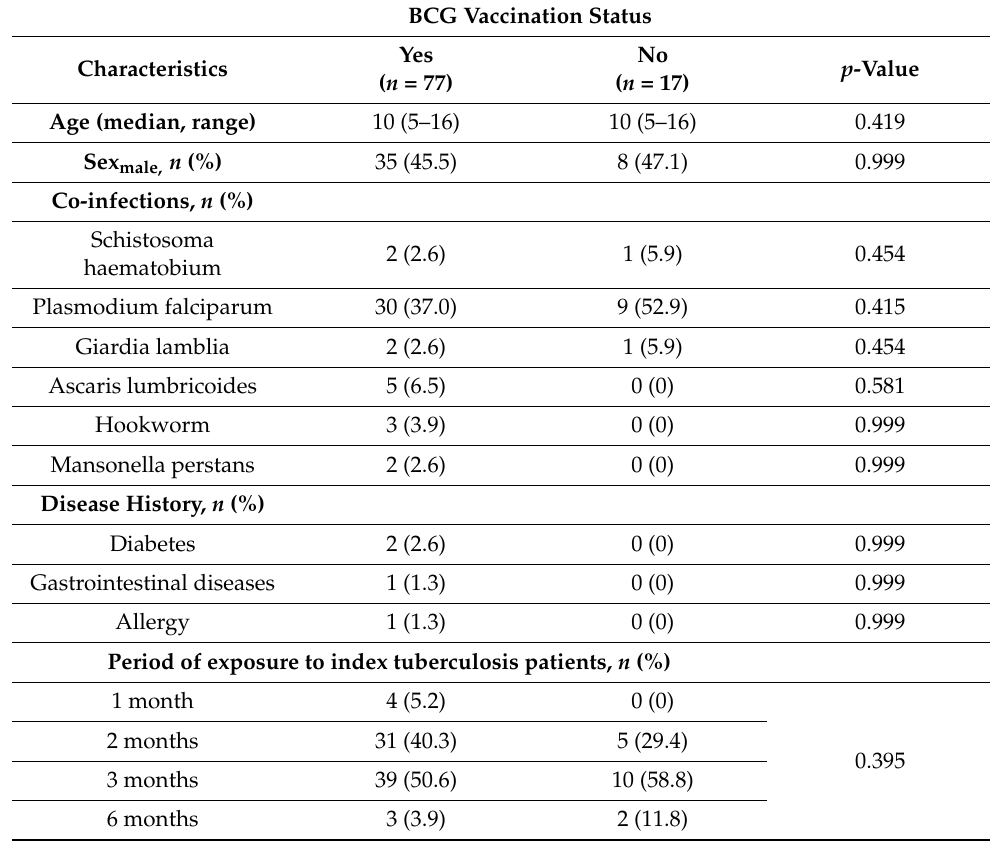
Table 1. Characteristics of Study Groups.